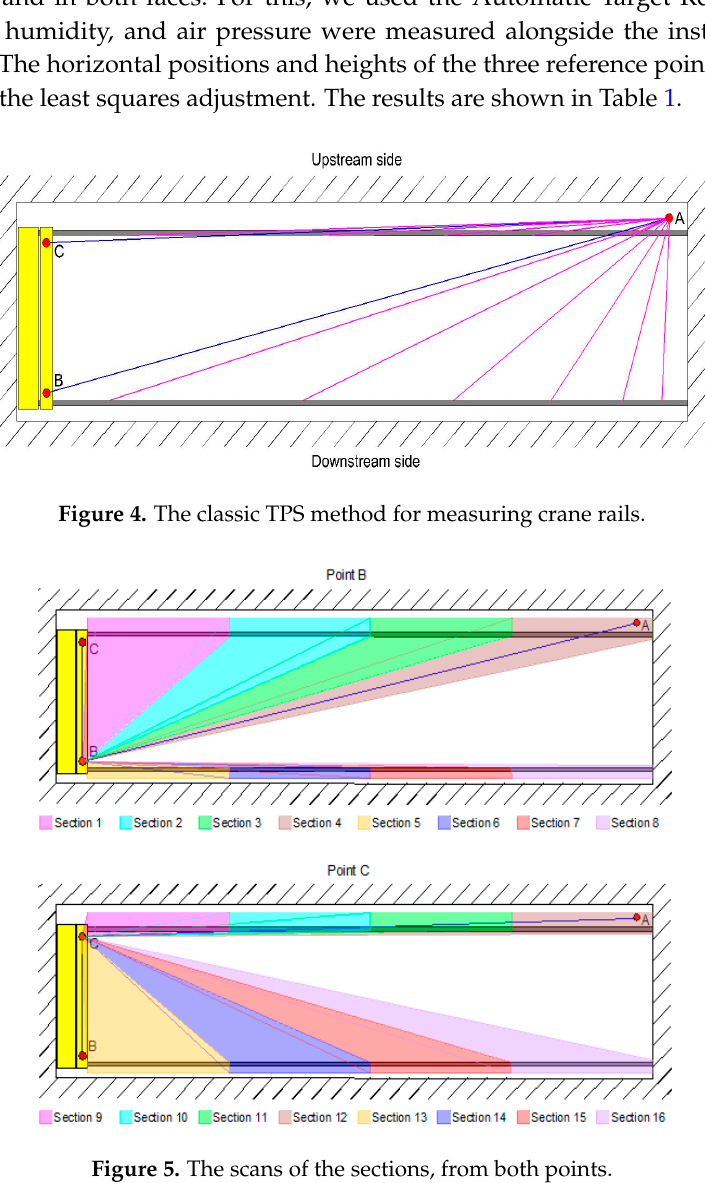
Figure 5. The scans of the sections, from both points.